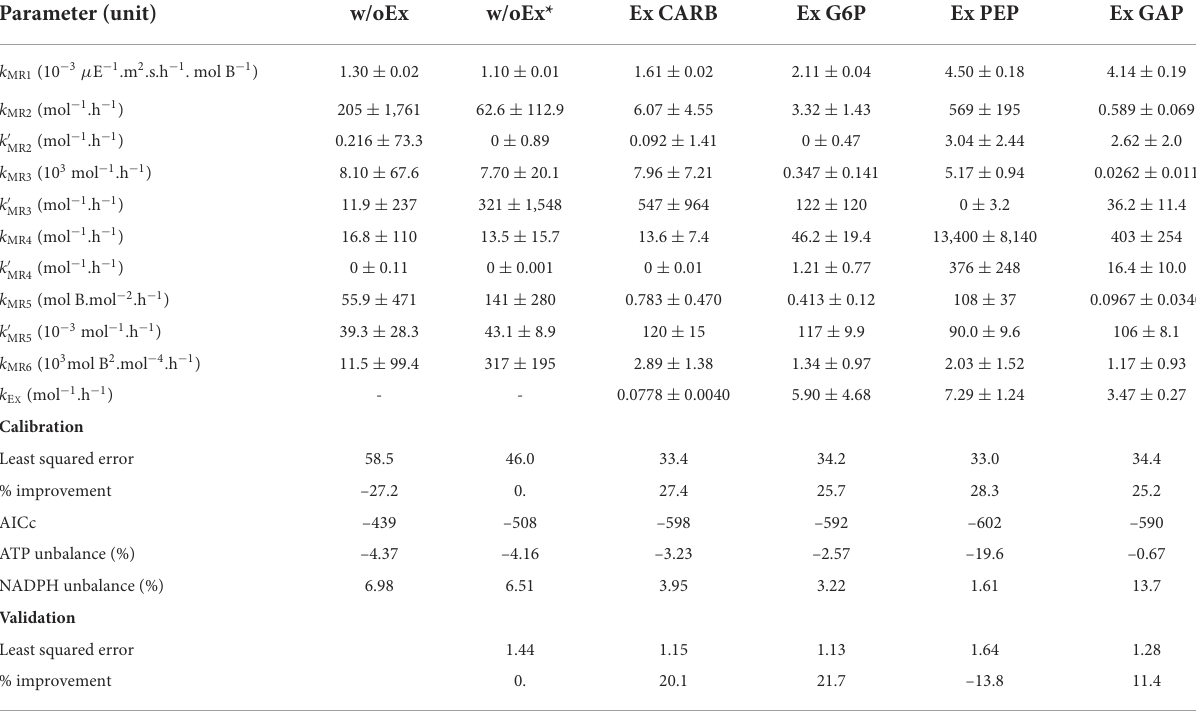
TABLE 2 Estimated kinetic parameters (with their standard deviations) and resulting least squared error. Parameter